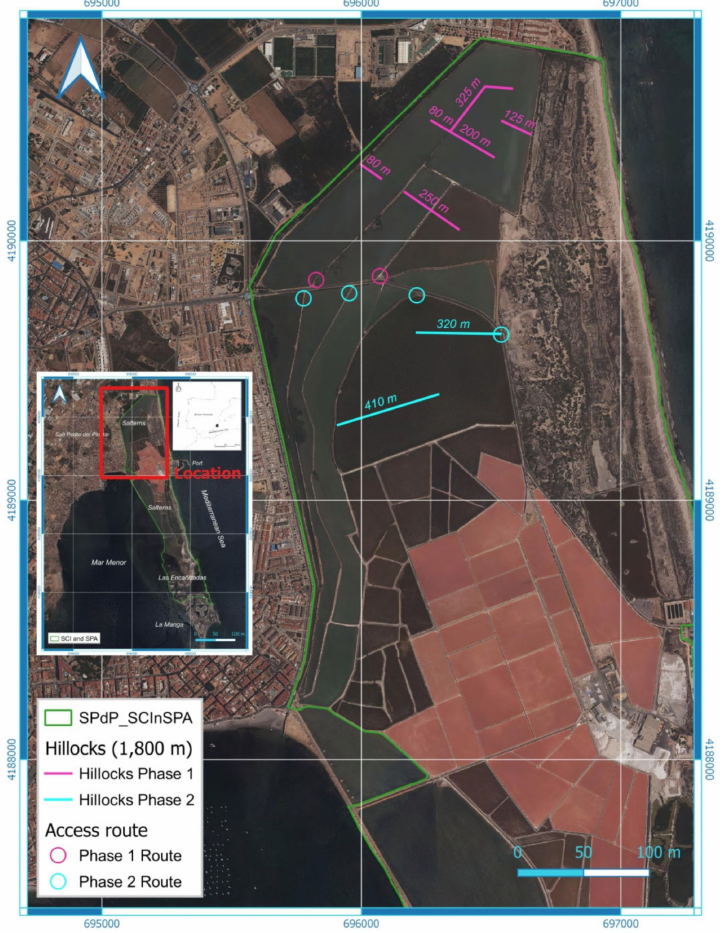
Figure 3. Adaptation of salt dams and reinforcement of accesses (Source: own elaboration).